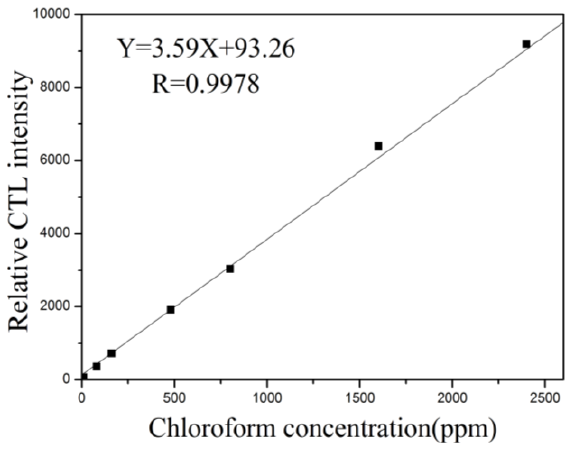
Figure 6. The calibration curve for chloroform, working temperature: 240 °C, carrier gas flow rate: 200